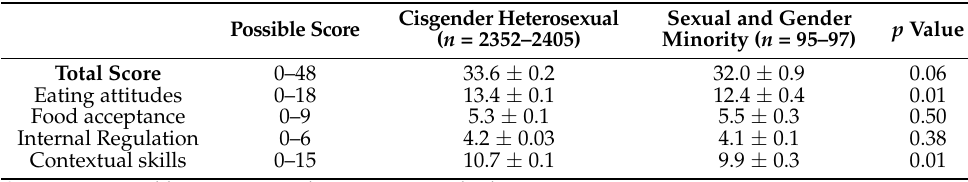
Table 2. Eating competence by sexual orientation and gender